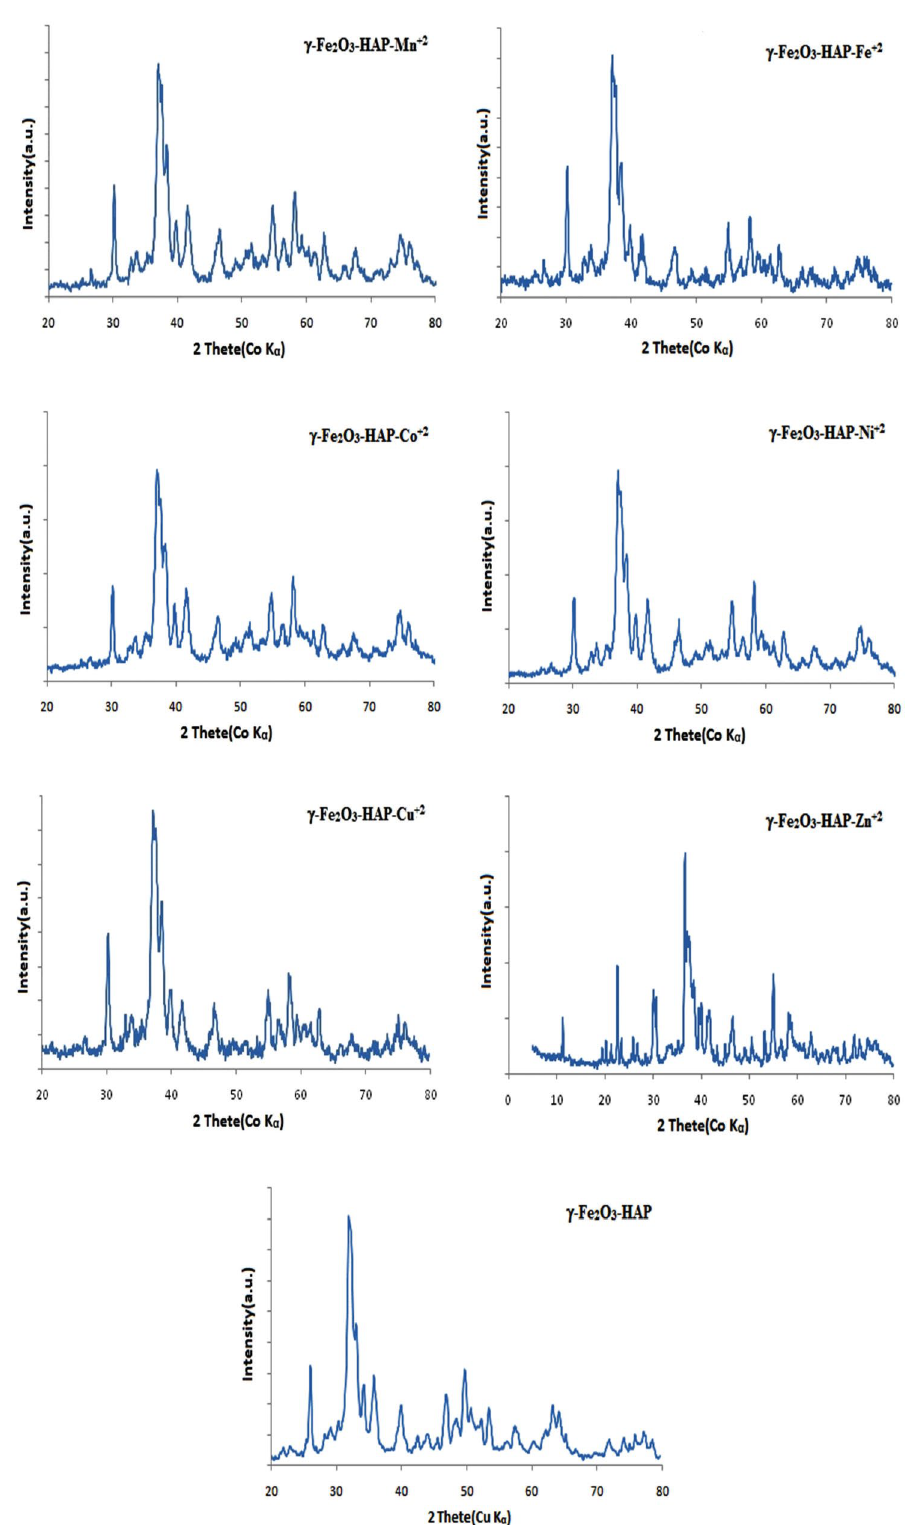
Fig. 2. The XRD patterns of γ-Fe